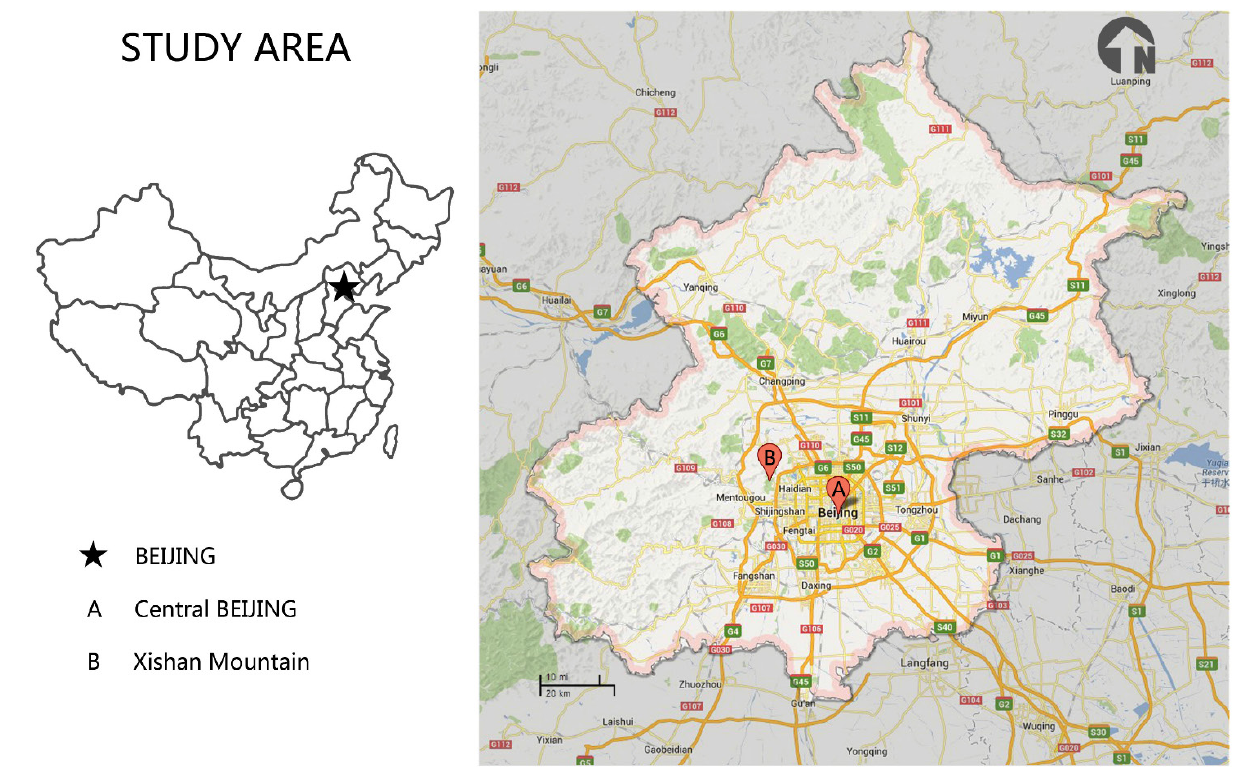
Figure 1. Location of the study area (redrawn by the author from Google